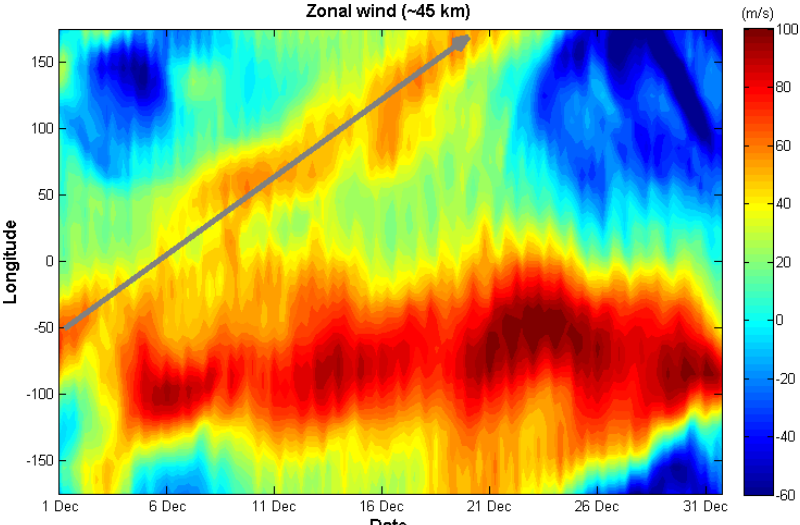
Figure 7. The temporal variation of zonal wind with longitude, averaged over 35–45 ◦ N near 45km obtained from ERA-Interim global atmospheric reanalysis